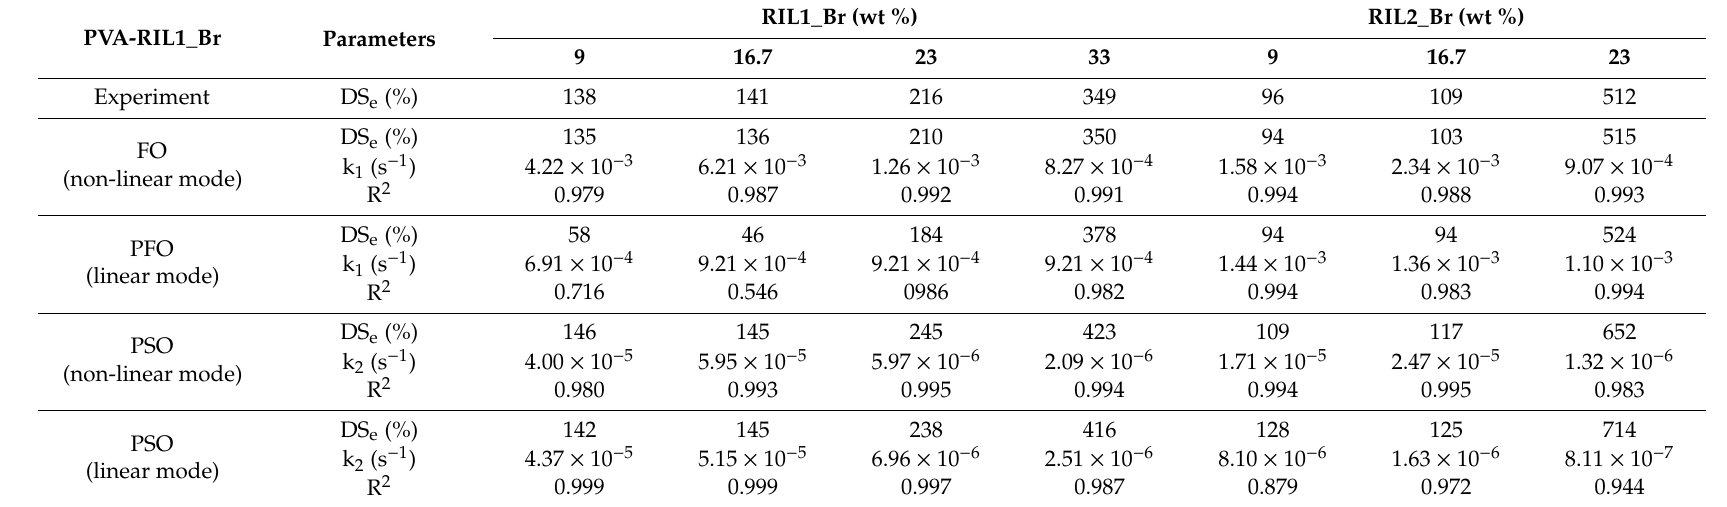
Table 6. The Estimated Kinetic Parameters of Two Sorption Models for Water Sorption of PVA-RIL1_Br and PVA-RIL2-Br Membranes at Room Temperature. PVA-RIL1_Br Experiment